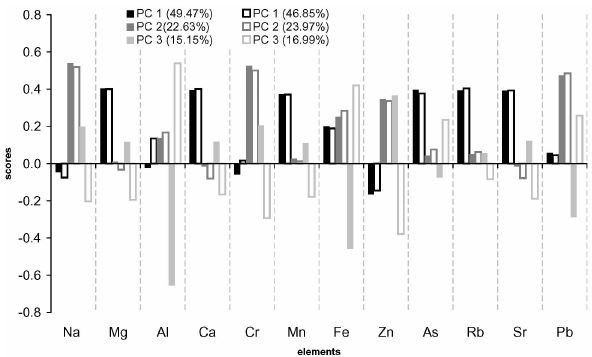
Fig. 5. PCA score coefficients represented as bars with heights pro- portional to the value of the coefficient. Filled and empty bars rep- resent the scores obtained from PCA established on the full dataset, and on the truncated dataset, respectively (for details see text). Vari- ance distributions of the first three PCs are given in parentheses for both